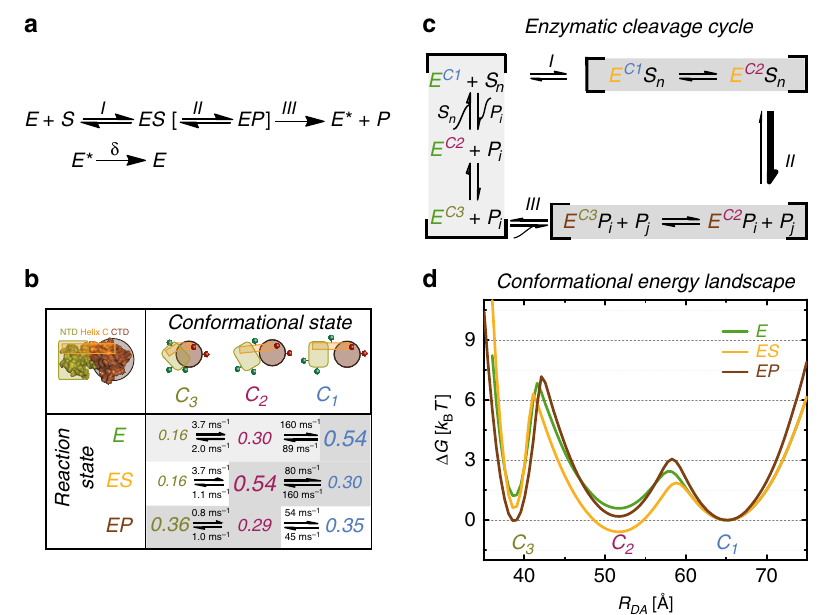
Fig. 7 Energy landscape of T4L. a Extended Michaelis – Menten scheme. b T4L interconverts between three major C 1 , C 2 , and C 3 conformational states. The population fractions of C 1 , C 2 , and C 3 are normalized to the variant S44pAcF/I150C in the absence of substrate using the relative changes in Fig. 6e to correct for the in fl uence of speci fi c mutations in that absence. The different font sizes represent the species fractions x i for each conformer according to Supplementary Table 2h and satisfy x 1 + x 2 + x 3 = 1. The three enzyme states are monitored via the following three enzyme variants: (i) the free enzyme state E via S44pAcF/I150C; (ii) the enzyme-substrate state ES via the inactive E11A/S44C/I150C with bound substrate; and (iii) the enzyme product state EP via the product adduct with T26E/S44pAcF/I150C after substrate cleavage. The reaction rate constants are calculated according to the process detailed in Supplementary Note 3, the con fi dence intervals of which are shown in Supplementary Table 4c. c The peptidoglycan chain with n subunits ( S n ) is cleaved into two products ( P i and P j with n = i + j ) by T4L, both of which can be further processed by T4L until only the dimer of N -acetylglucosamine and N -acetylmuramic acid remains. The gray shaded steps indicate the conformational/reaction states observed. d Relative Gibbs free energy landscapes are (cid:1) (cid:3) T ln k ji calculated using Δ G 0 ¼ (cid:2) k , where k B is the Boltzmann constant and T is the temperature; k ij are the reaction rate constants between states C i and C j (cid:1) (cid:3) k ij B T ln k ji assuming k 0 = 10 3 ms − 1 as an arbitrary constant. The for the data presented in ( a ). The activation energies are calculated according to Δ G 0 þ ¼ (cid:2) k k 0 B distributions consider C 1 , C 2 , and C 3 to follow a Gaussian distribution as a function of the interdye distance R DA . The Gaussian widths ( σ ι ) are adjusted to satisfy the energy differences and calculated activation energies. Each energy landscape is independently normalized to C 1